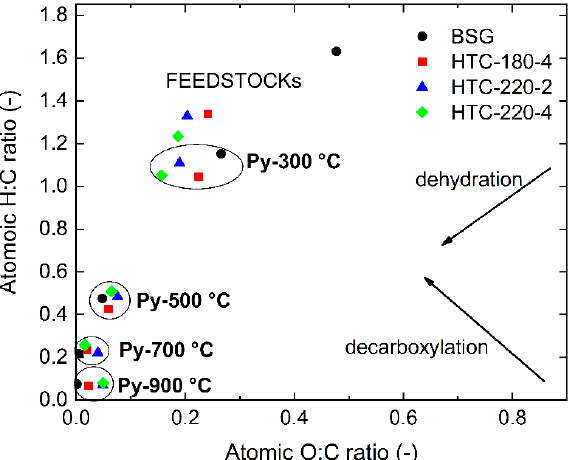
Figure 2. Van Krevelen diagram for feedstocks and pyrochars produced at 300, 500, 700, and 900 ◦